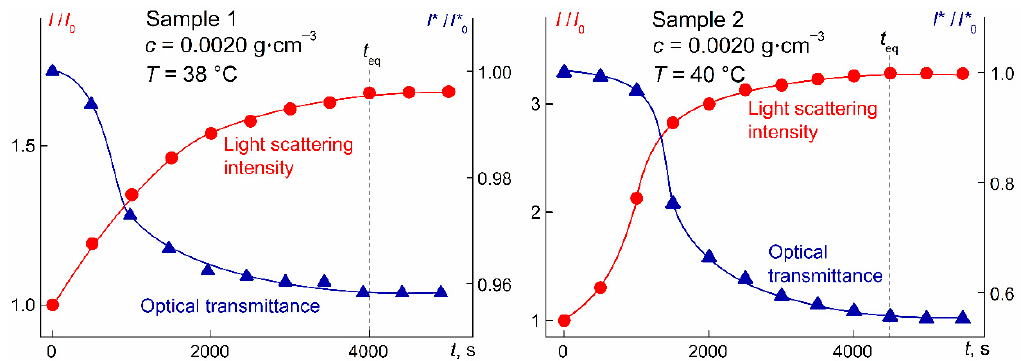
Figure 2. Time dependencies of intensities of light scattering I and transmitted light I * for the aqueous solution of PDMS- g - PiPrOx. I 0 and I * 0 are intensities of light scattering and optical transmittance at t = 0, respectively.